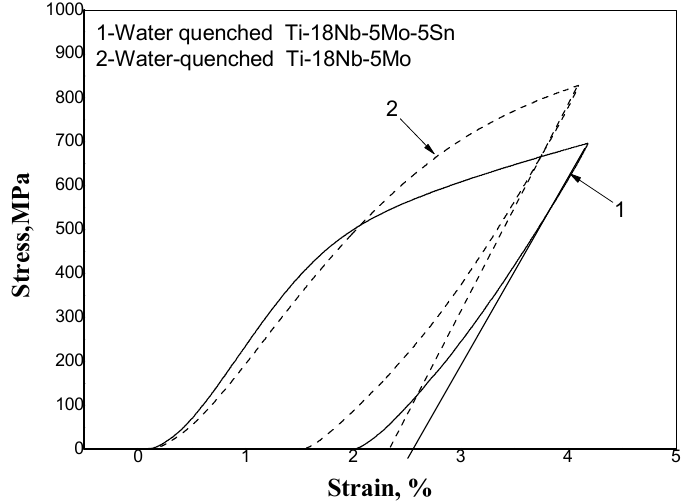
Figure 6. The stress–strain curves of the water-quenched Ti-18Nb-5Mo and Ti-18Nb-5Mo-5Sn al- loys.